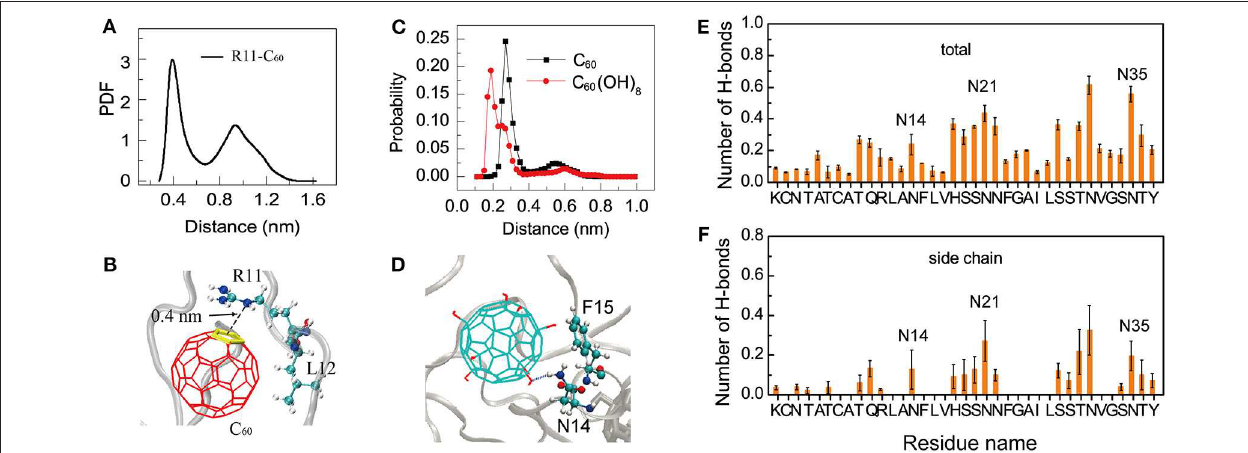
FIGURE 5 | Binding mechanism of C 60 /C 60 (OH) 8 on hIAPP dimer. (A) PDF of the minimum distance between NE atom of R11 and the geometry center of the C 60 ring; (B) a representative snapshot showing the cation- π interaction between the atom NE in residue R11 and the ring of C 60 ; (C) probability distribution of the minimum distance between N14/N21/N35 and C 60 /C 60 (OH) 8 . (D) A representative snapshot showing the collective hydrophilic and aromatic-stacking interactions between C 60 (OH) 8 and hIAPP. (E) Total number of H-bonds between C 60 (OH) 8 and each residue of hIAPP. (F) Number of H-bonds between C 60 (OH) 8 and the side chain of each hIAPP